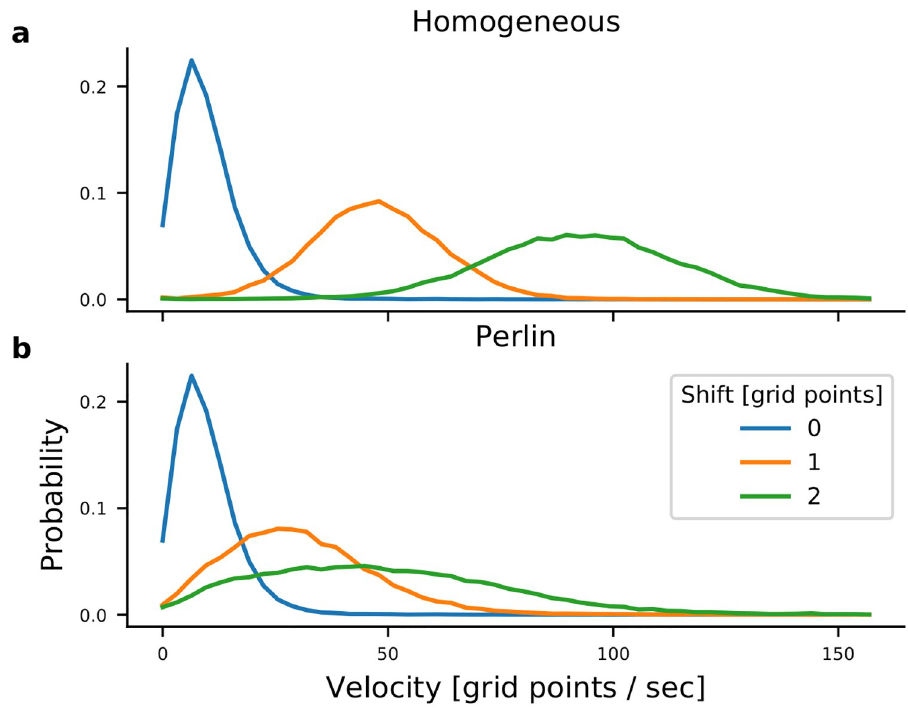
Fig 5. Velocity of neuronal activity sequences. Distribution of the velocity of neuronal activity sequences in I- networks with homogeneous ( a ) and Perlin ( b ) configurations. The velocity of the activity sequences increased with the increase in connectivity asymmetry. Note that the velocity of activity bump movements in networks with symmetric connections (blue traces) were identical in networks with homogeneous and Perlin configurations. However, for any non-zero degree of asymmetry (orange and green traces) the velocity of activity bump movements was higher in networks with the homogeneous